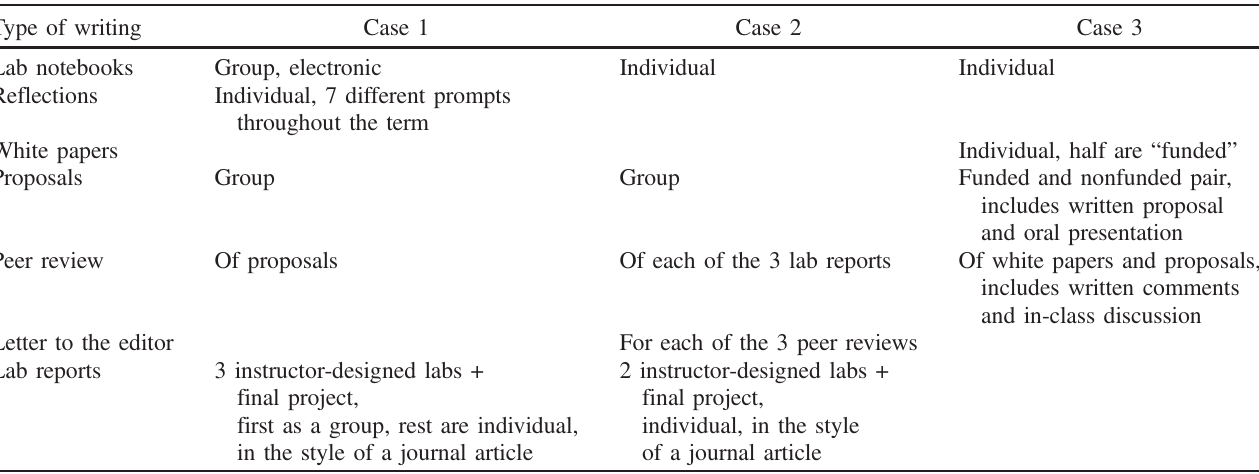
TABLE I. Implementation of writing in each of the three cases. Each cell indicates whether a given writing assignment is included for each case. “ Group ” indicates the writing is completed by a group of students, and “ individual ” indicates that each individual student turns in their own